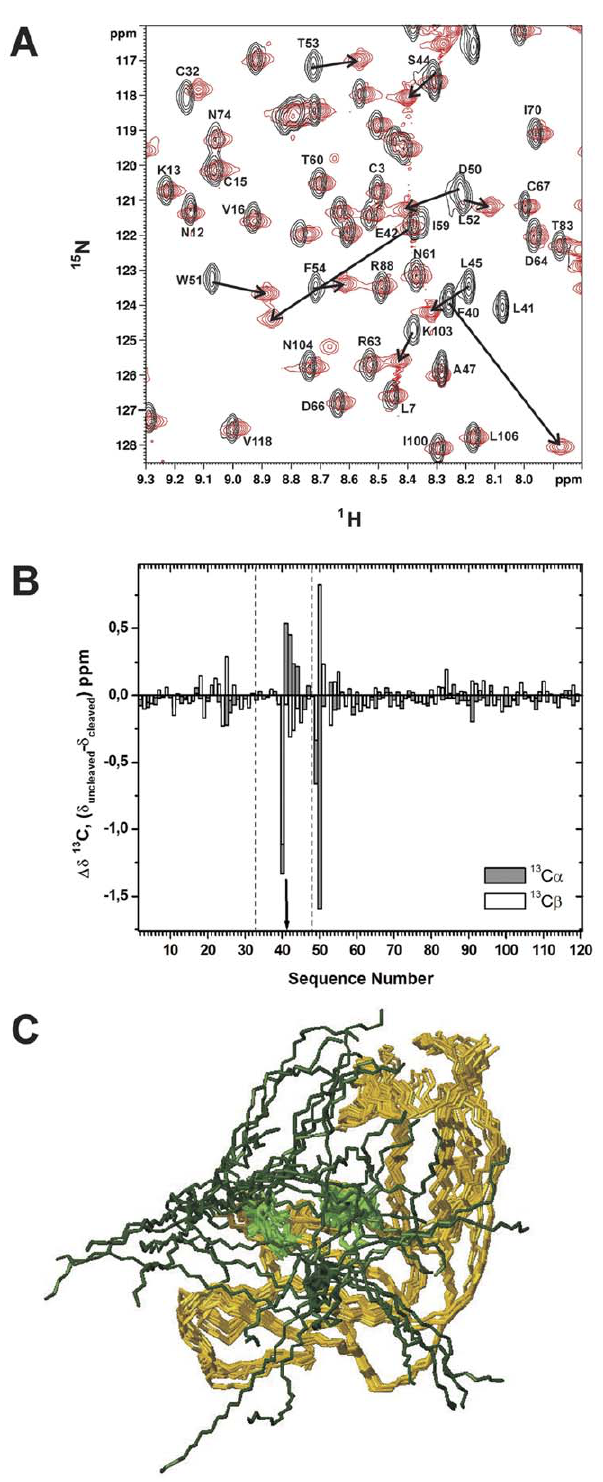
Figure 5. NMR data and structural model of the cleaved ONCFLG variant. (A) Region of the 2D 1 H- 15 N HSQC spectra of the 15 N labeled ONCFLG variant (black) superimposed onto that of cleaved form (red). Spectra were recorded at 800 MHz, 35 u C and pH 5.2. Represen- tative 1 H- 15 N correlations of the uncleaved form are labeled and black arrows indicate the corresponding shifted signals in the cleaved ONCFLG form. (B) Comparison of the 13 C a and 13 C b chemical shift values for the uncleaved and cleaved forms of ONCFLG variant.